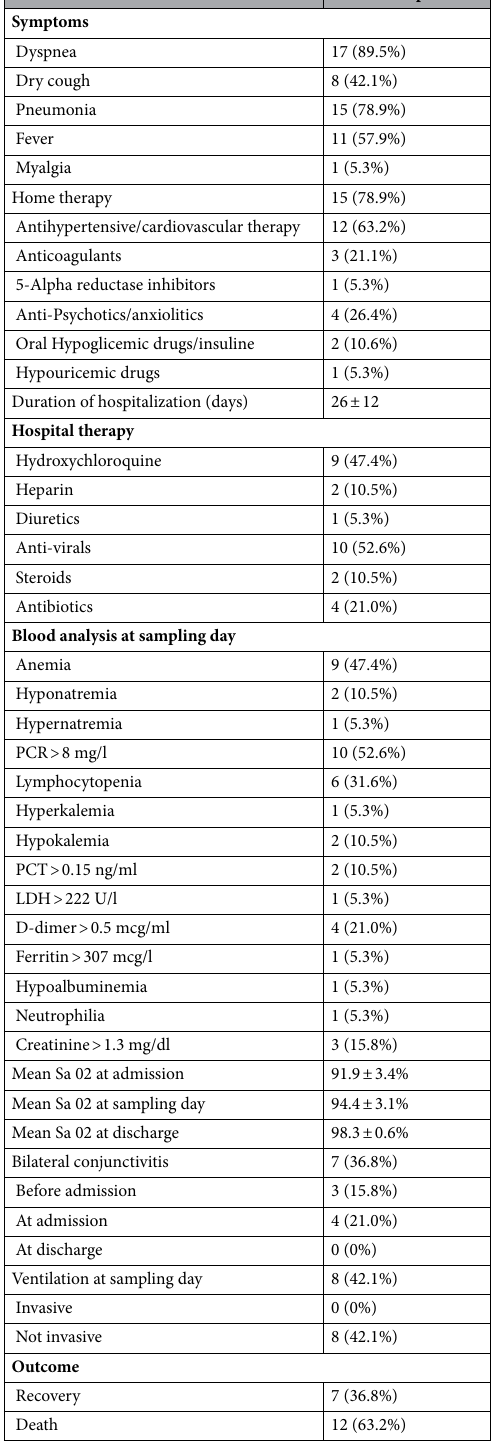
Table 2. Medical history and clinical characteristics of patients with